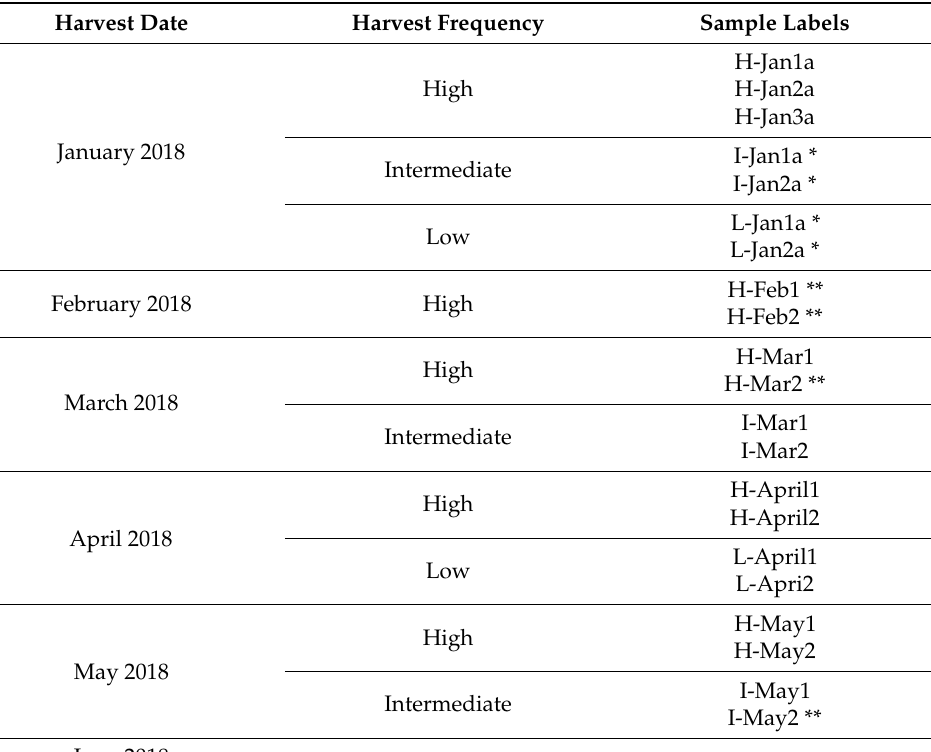
Table 1. Sampling scheme for M. oleifera leaves extracts used for NMR metabolomics